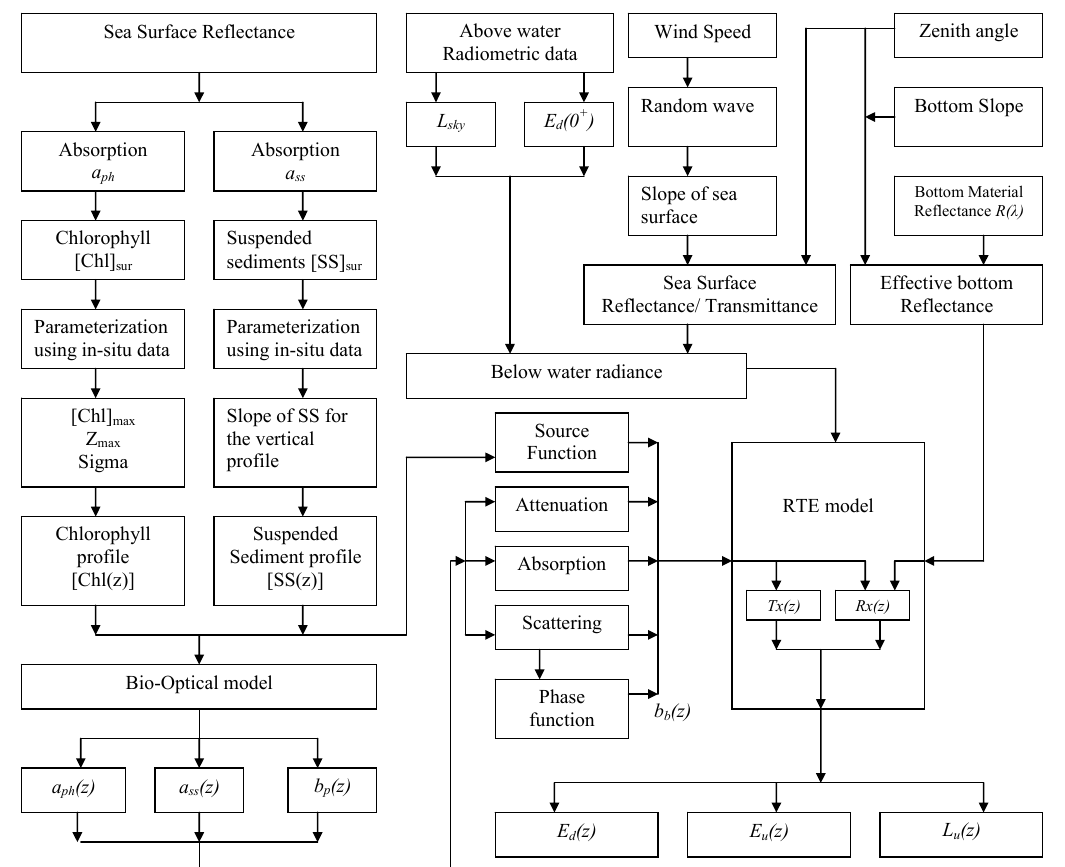
Figure 1. The schematic block diagram indicates the overall system for the simulation of underwater light fields using the present RT model with the in situ IOP (right) or predicted IOP from remote-sensing data (left) along with other input parameters.